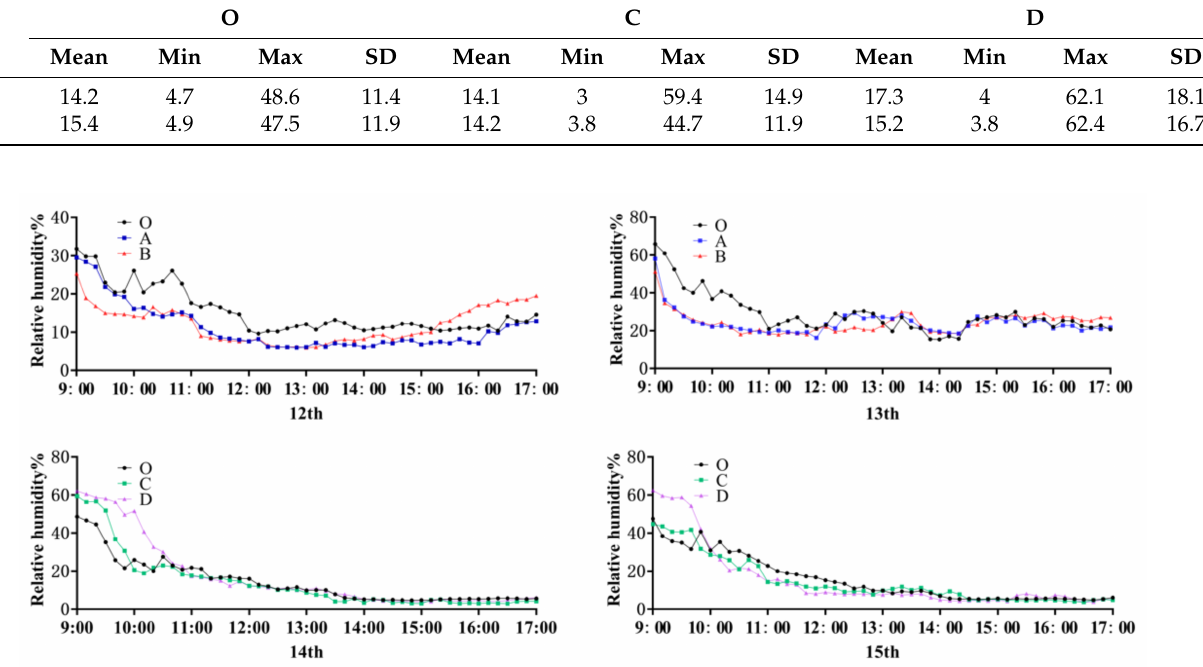
Figure 7. Comparison of relative humidity changes in different